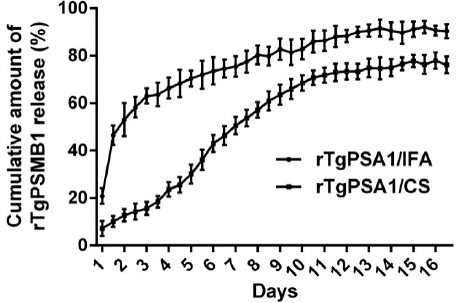
Figure 3. Release profile of rTgPSA1/CS nanospheres and rTgPSA1/IFA emulsion in vitro over a 16-day period. Amount of recombinant protein in supernatant was determined by BCA assay. Each sample was tested once. Values represented as mean ± SD (n = 3).